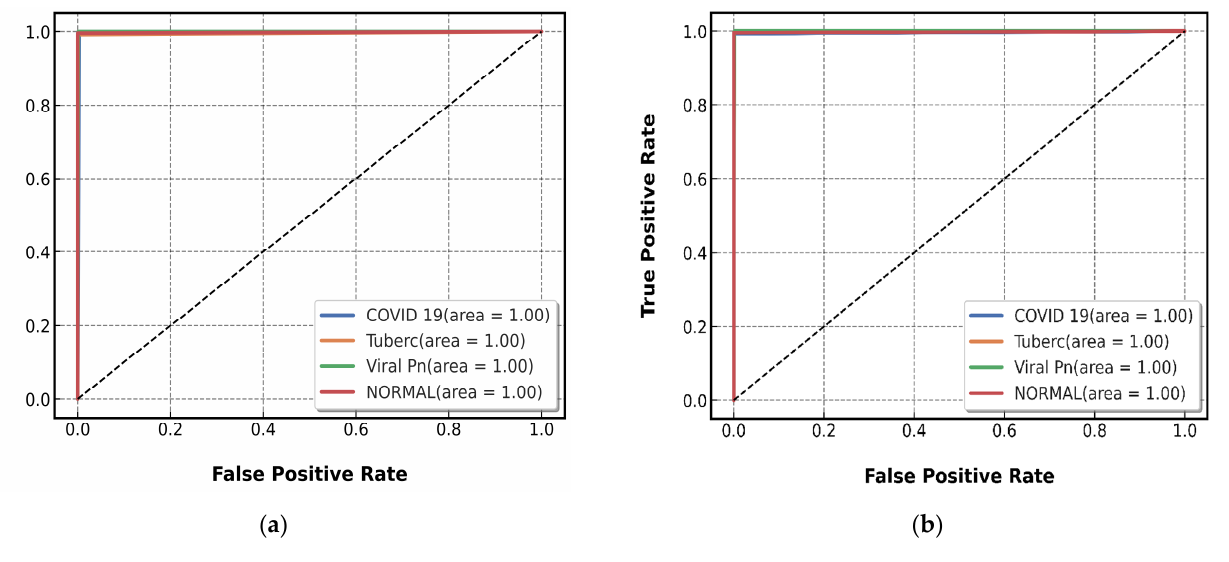
Figure 10. ROC curves obtained by the Proposed Concatenation classifier. ( a ) Proposed concatenation model based on the modified ResNet50 V2 and MobileNet V2 models, ( b ) Proposed concatenation model based on the modified Xception and Inception V3 models. Table 14. Evaluation Models’ performance based on metrics